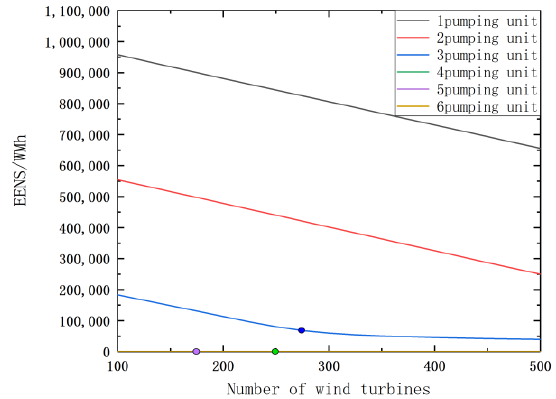
Figure 10. Probability of load loss (LOLP) for different capacity configuration schemes.